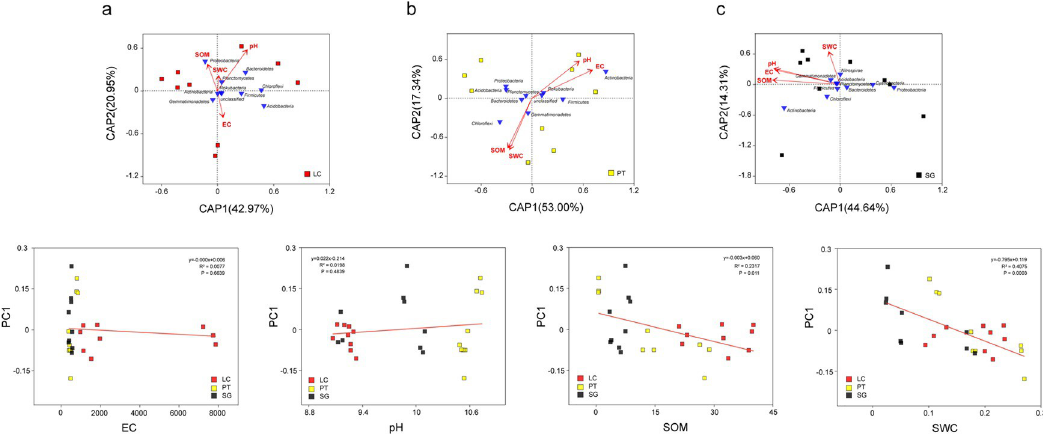
Fig 4. RDA analysis between bacterial communities (phylum level) and soil properties of LC (a), PT (b) and SG (c). Linear regression analysis at the phylum level between the PCA1 and pH, EC, SOM, SWC. SOM—soil organic matter; SWC—soil water content. LC, Leymus chinensis (Trin.) Tzvel.; PT, Puccinellia tenuiflora (Griseb.) Scribn. et Merr.; SG, Suaeda glauca (Bunge) Bunge.